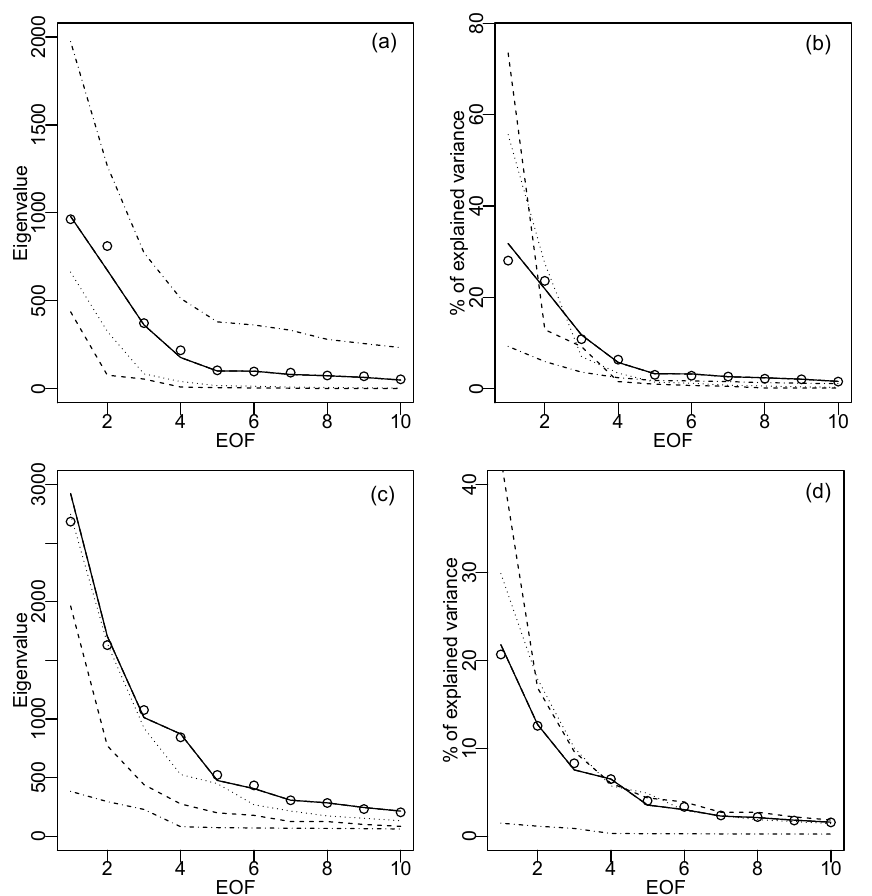
Figure 4. Eigenvalues (a, c) and percentage of explained variance (b, d) of temperature at 2m (a, b) and precipitation (c, d) in winter over the evaluation period for: SAFRAN (circles); ERA-I (dashed); 1d-BC by CDF-t (dotted); 2d-R 2 D 2 (dashed-dotted); 1506d-R 2 D 2 (T2 or PR, long dashed); 3012d-R 2 D 2 (solid line). Note that results of the 1506d- (long dashed) and 3012d-R 2 D 2 (solid line) versions are the same and are therefore superimposed.